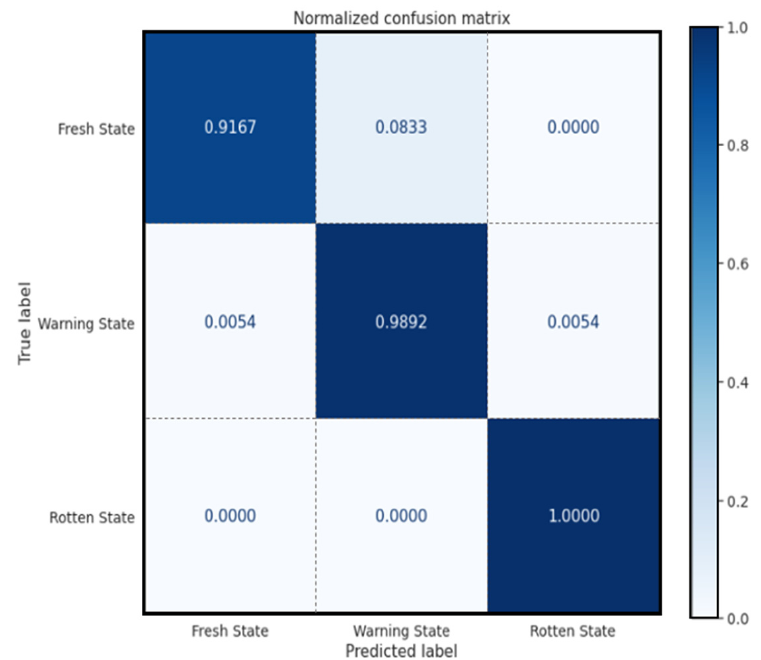
Figure 12. SVM classi fi cation results.